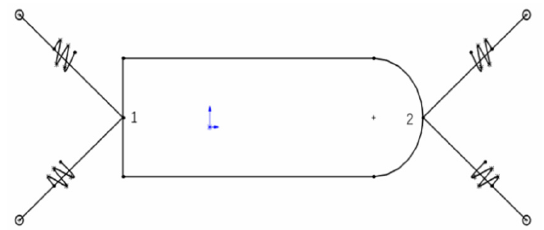
Figure 6. Schematic diagram of the horizontal soft